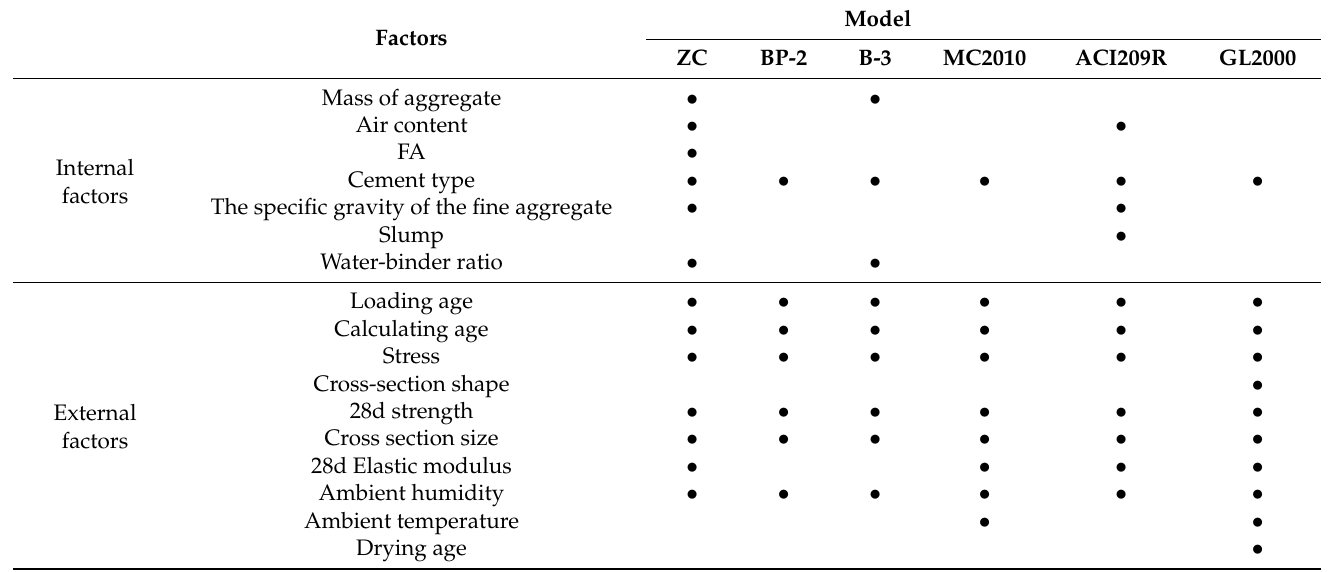
Table 1. Factors being considered in six prediction models of tensile creep.